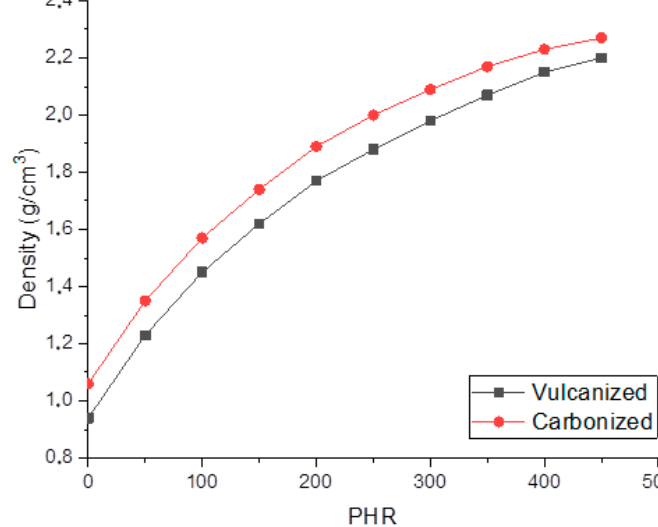
Figure 4. Dependencies of vulcanized and carbonized composites density on the filling degree.